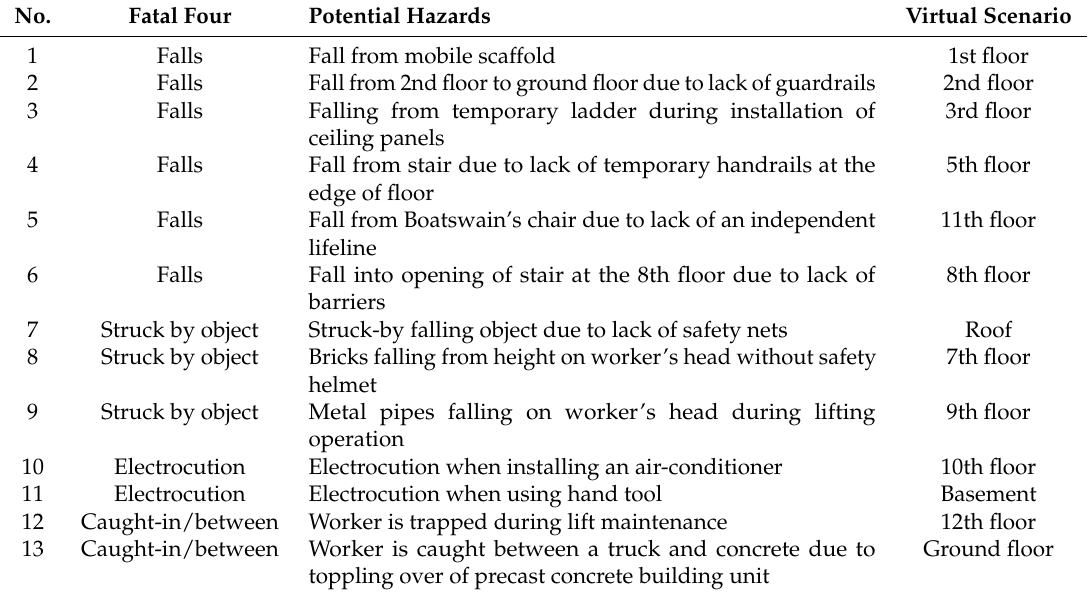
Table 2. Case studies for construction hazard